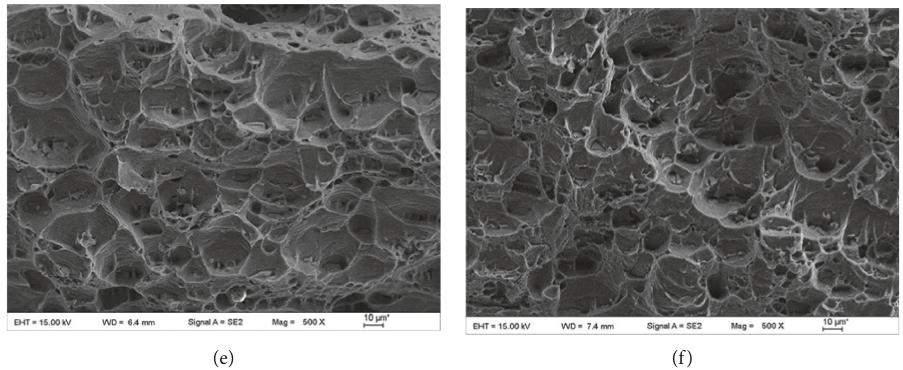
Figure 9: SEM fractographs of FSW specimens: (a) Sample 1; (b) Sample 2; (c) Sample 3; (d) Sample 4; (e) Sample 5; (f) Sample